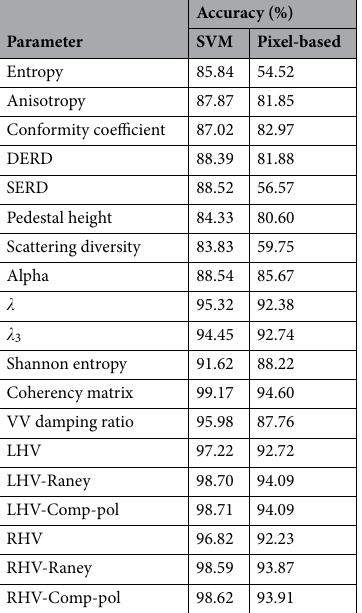
Table 6. Achieved accuracy with all tested parameter for each class using SVM classifier and the pixel-based